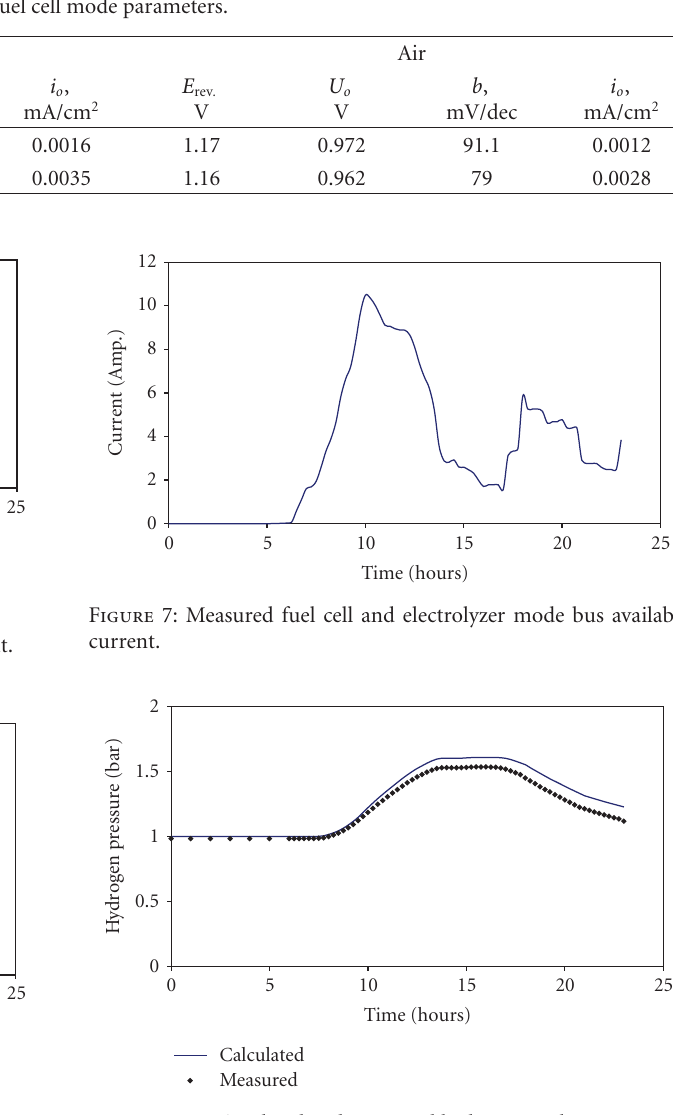
Figure 6: Fuel cell mode voltage and electrolyzer mode voltage.